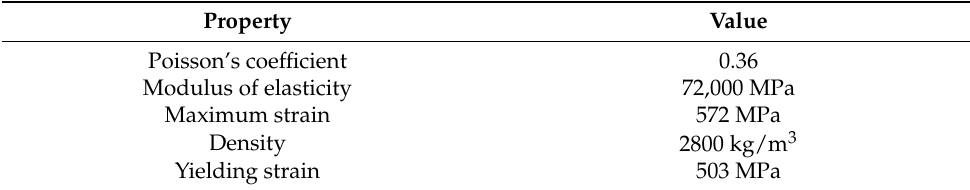
Table 5. Mechanical properties of the 7075-O.